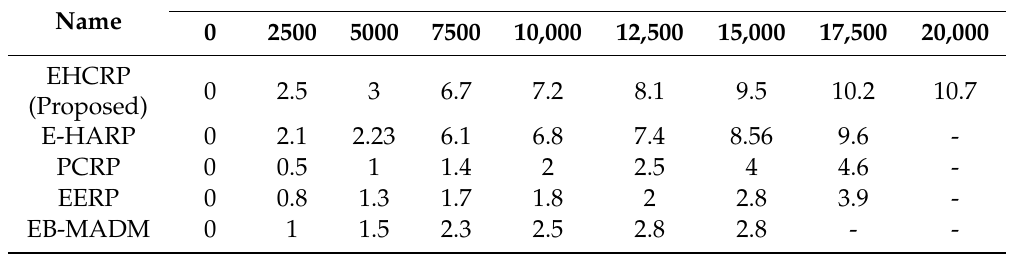
Table 7. Network throughput vs. time (s).